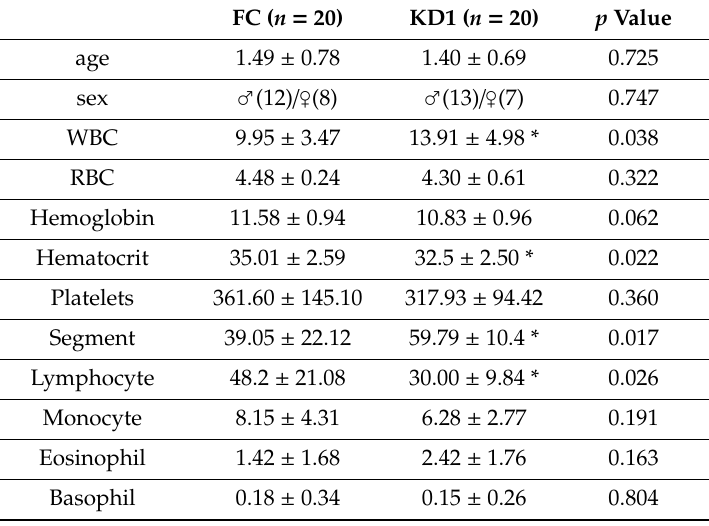
Table 3. Demographic and Clinical Characteristics of Enrolled Patients.